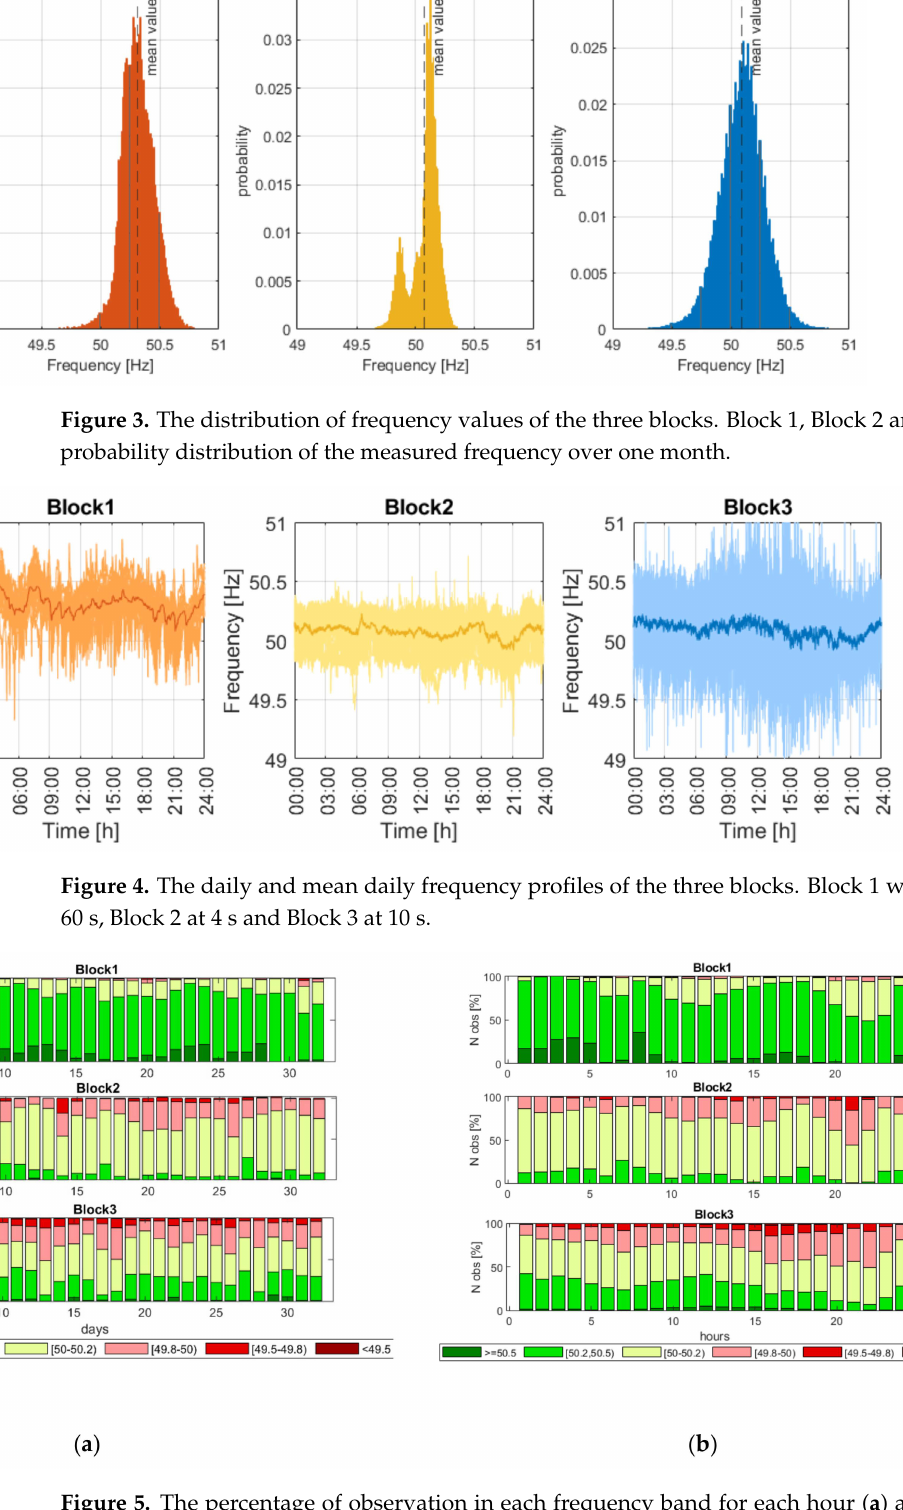
Figure 5. The percentage of observation in each frequency band for each hour ( a ) and day of the month ( b